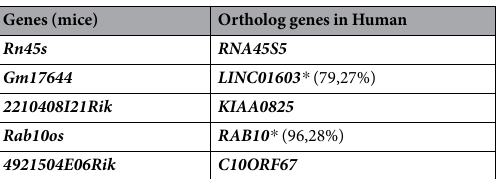
Table 2. Homologous genes in Human. * Orthologs unknown, genes selected by sequence similarity (%) through BLAST